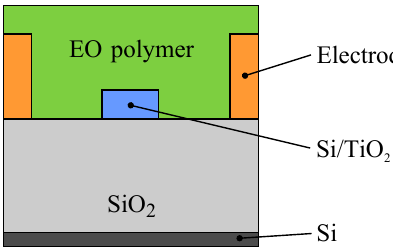
Figure 1. Straightforward design of an electro-optic (EO) polymer based phase shifter, where the EO polymer is used as cladding